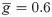
Variance of MLE of N when θ is unknown relative to when it is known, for various sample sizes based on simulation, and asymptotically from Eq (26), where P = 0.1, c = 1 and g¯=0.6.